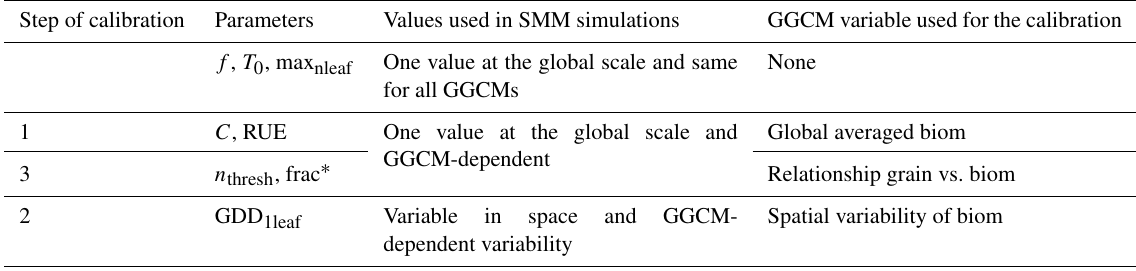
Table 2. Strategy of SMM calibration for each